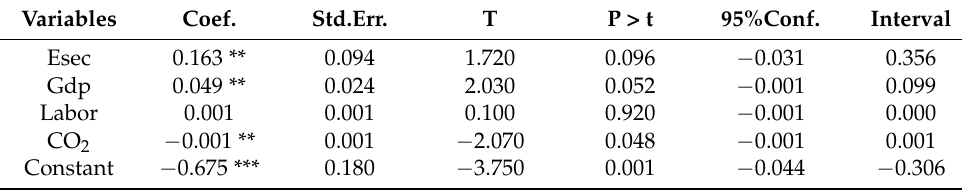
Table 7. Regression with Driscoll–Kraay standard